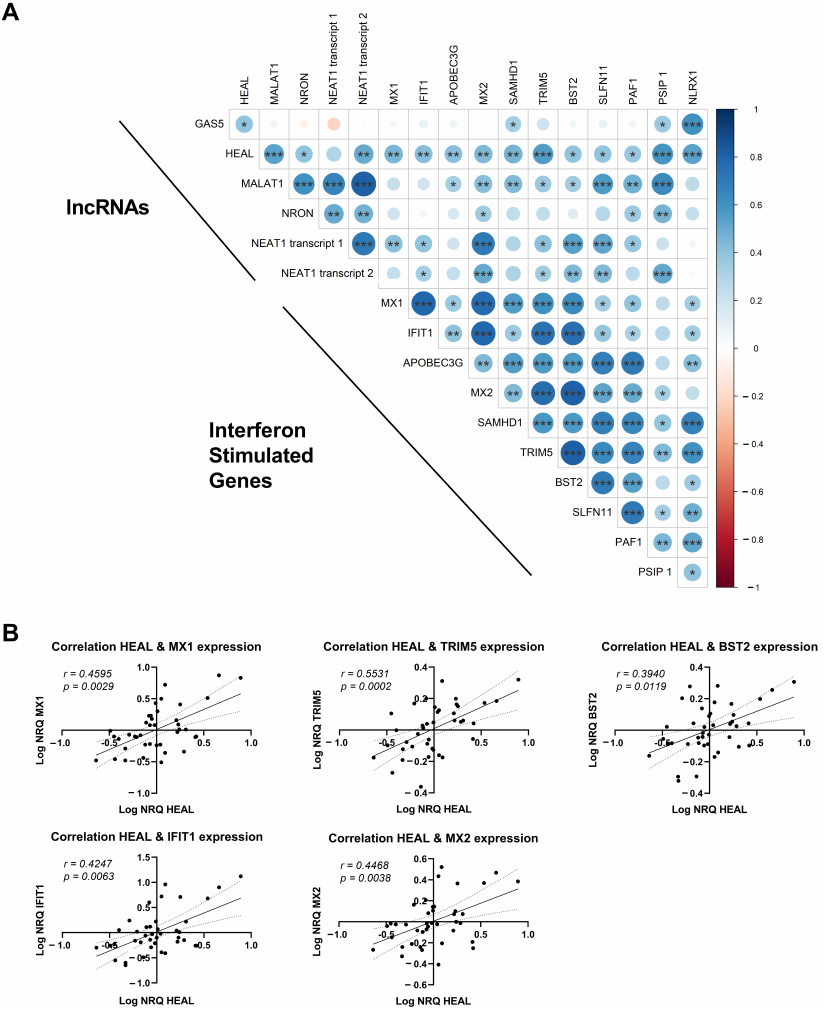
Figure 4. Correlation of lncRNA expression and the expression of interferon stimulated genes. ( A ) Correlation plot indicates the correlation between lncRNA expression and the expression of ISGs in participants undergoing ATI. Spearman correlations were calculated over all timepoints, including all participants. Positive and negative correlations are depicted in blue and red, respectively. Significant correlations are indicated with asterisks ( p < 0.05 *, p < 0.01 ** and p < 0.001 ***). ( B ) Spearman correlation plot of the expression of HEAL and restriction factors observed to be upregulated in previous work [18]. In all plots the Spearman r is reported, as well as the p